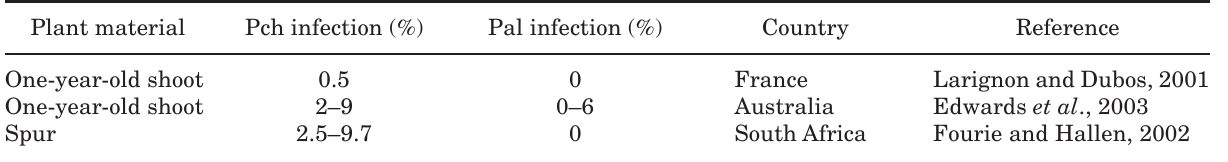
Table 2. Incidence (%) of P. chlamydospora (Pch) and/or P. aleophilum (Pal) in the shoots of mother vines. Plant